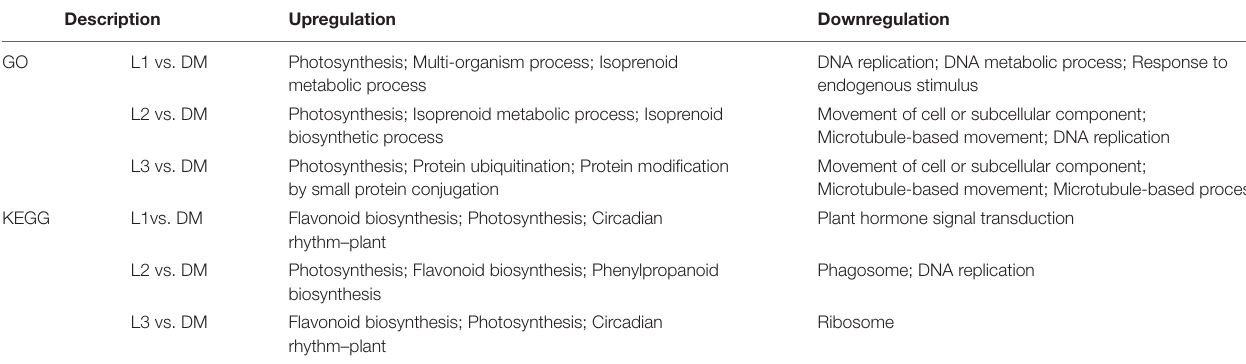
TABLE 2 | GO and KEGG enrichment analysis of DEGs in L vs. DM comparisons.